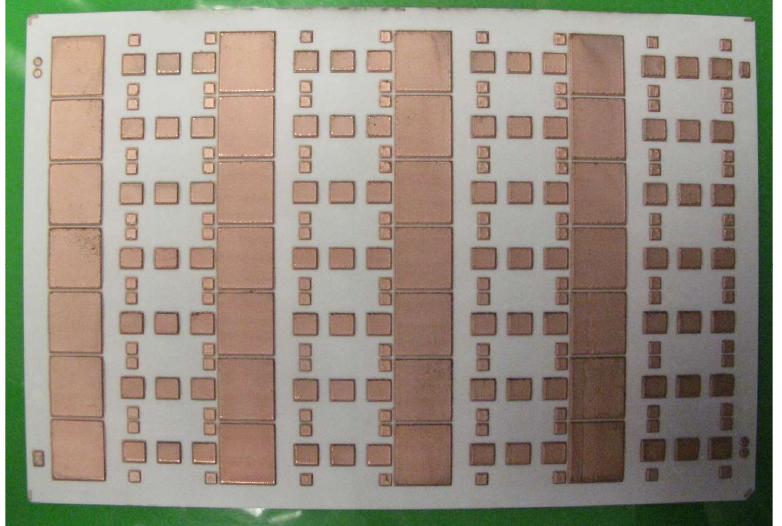
Figure 15. An entire Al 2 O 3 plate with copper electrodes reduced with forming gas 95/5 plasma jet and argon plasma bridge. The treatment conditions are summarized in Table